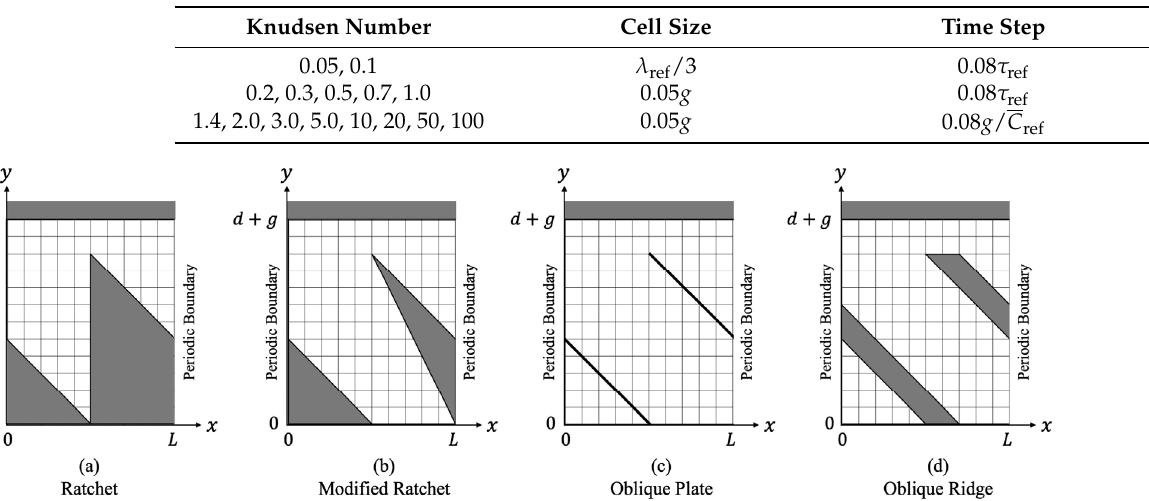
Table 1. Parameters for the DSMC Simulation for the different Knudsen number cases.